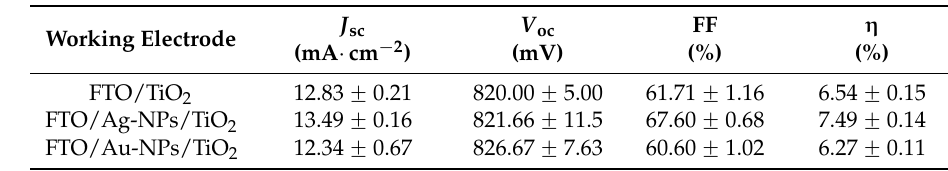
Table 1. Photoelectric performance of the three cells shown in Figure 2. J sc : The short-circuit current; V oc : the open-circuit voltages; FF: Fill Factor; η : efficiency; FTO: fluorine-doped tin oxide; NPs: nanoparticles.